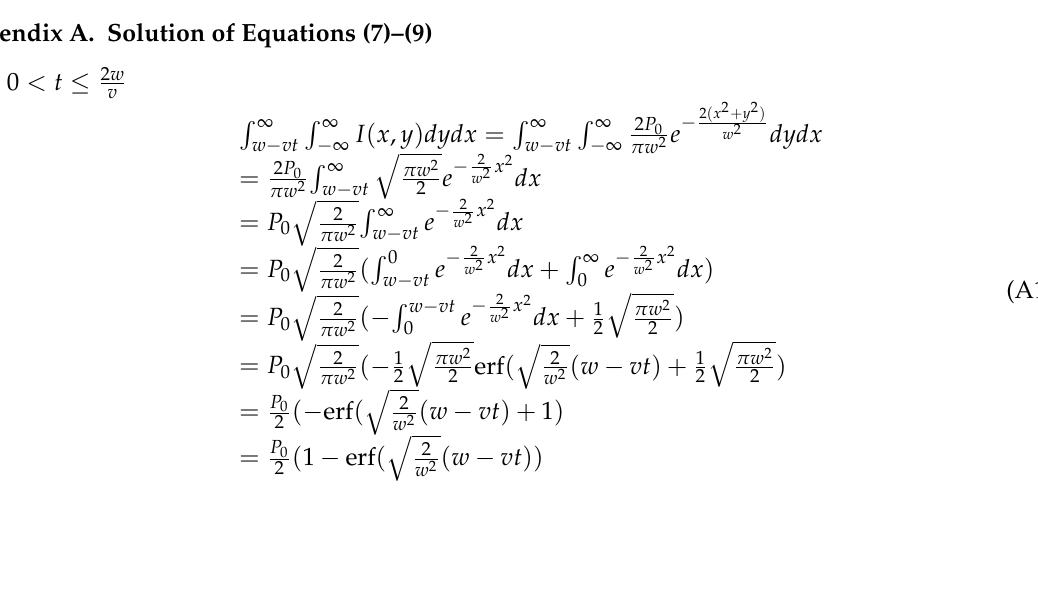
Figure 12. SEM images with a laser power of 50 W. Figure 13. SEM images with a laser power of 50